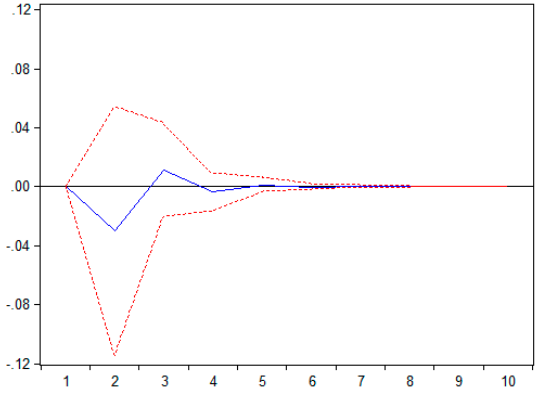
Figure 3. Daily banks’ stock price percentage change impulse response to a unit shock of the redenomination risk growth rate. Source: authors’ calculations in Eviews 10 based on Bloomberg data.